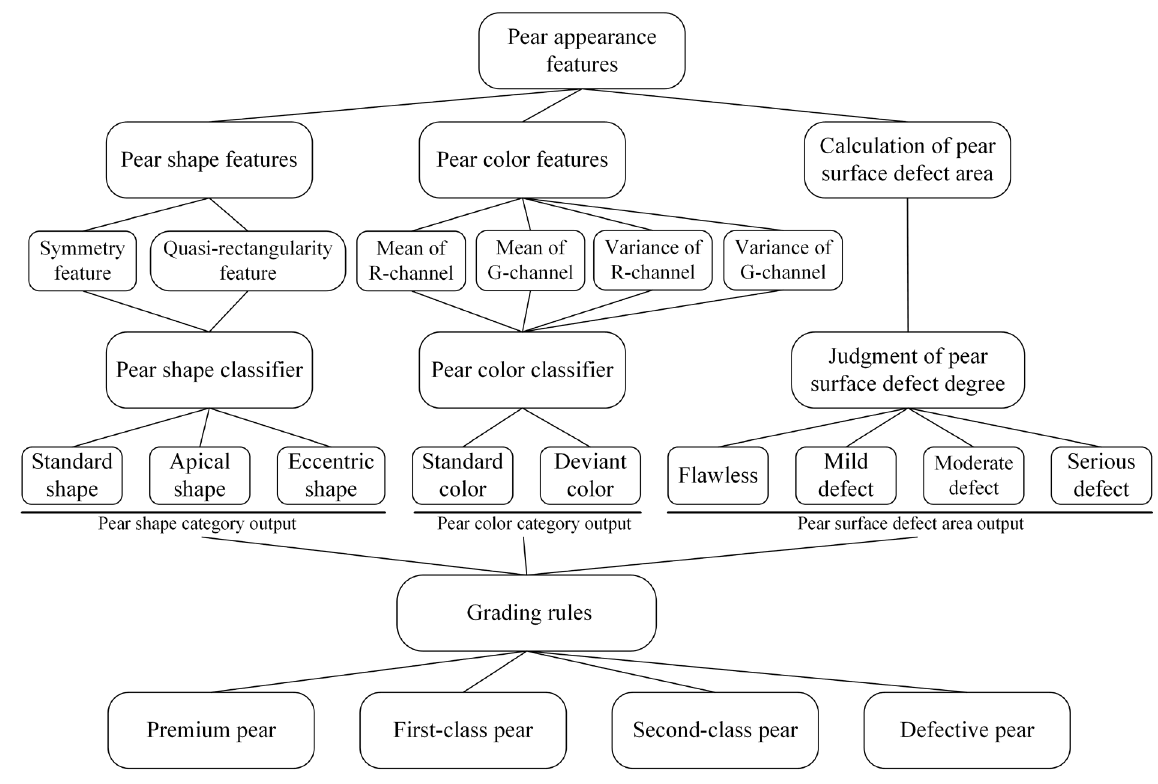
Figure 6. Grading method.